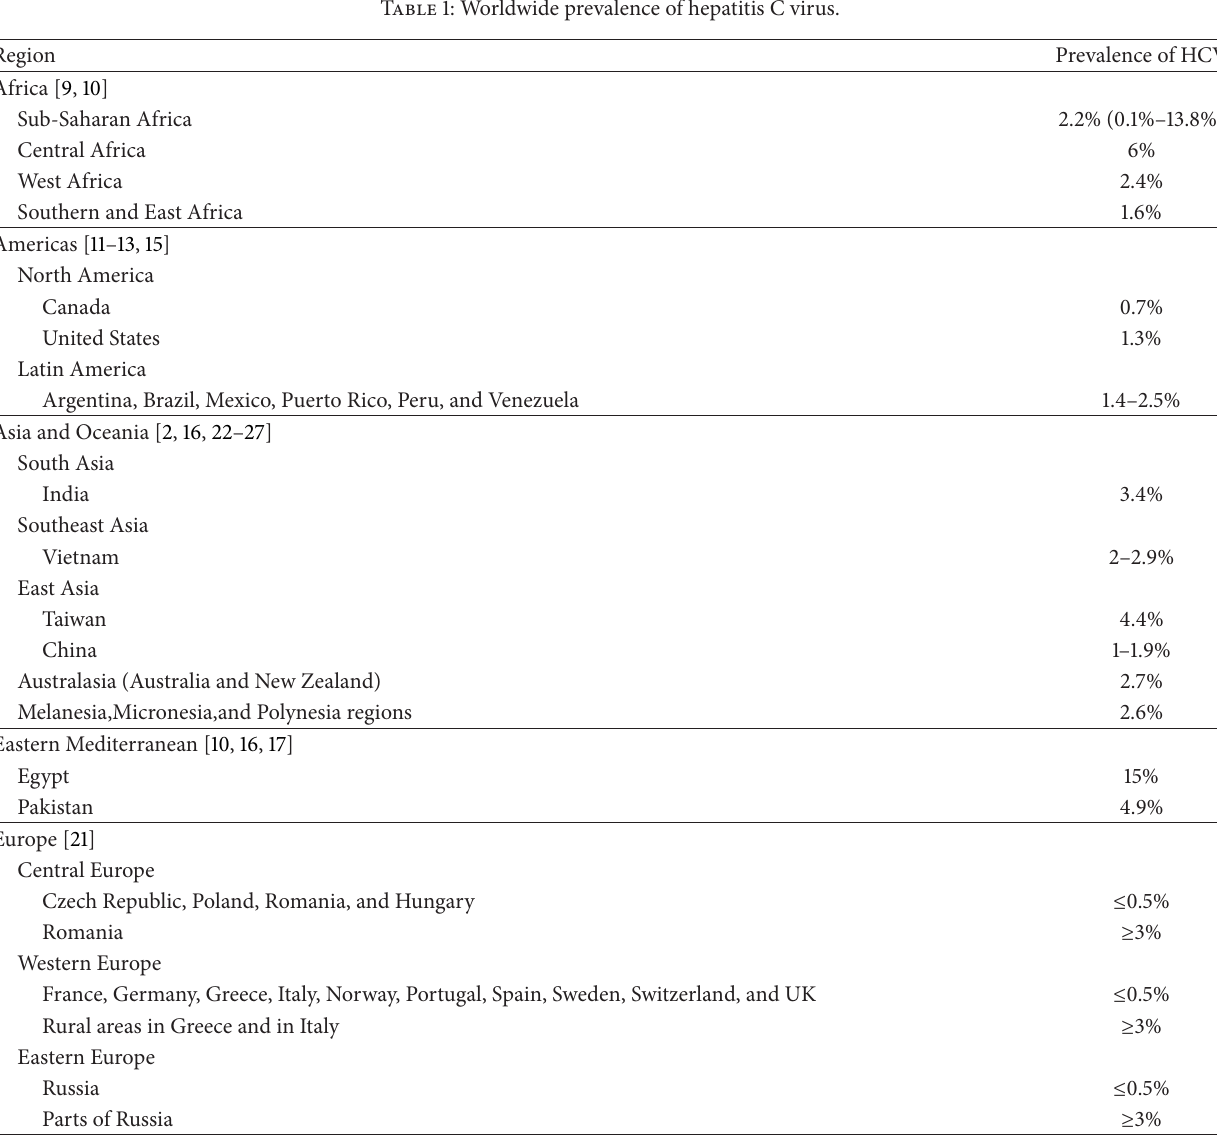
Table 1: Worldwide prevalence of hepatitis C